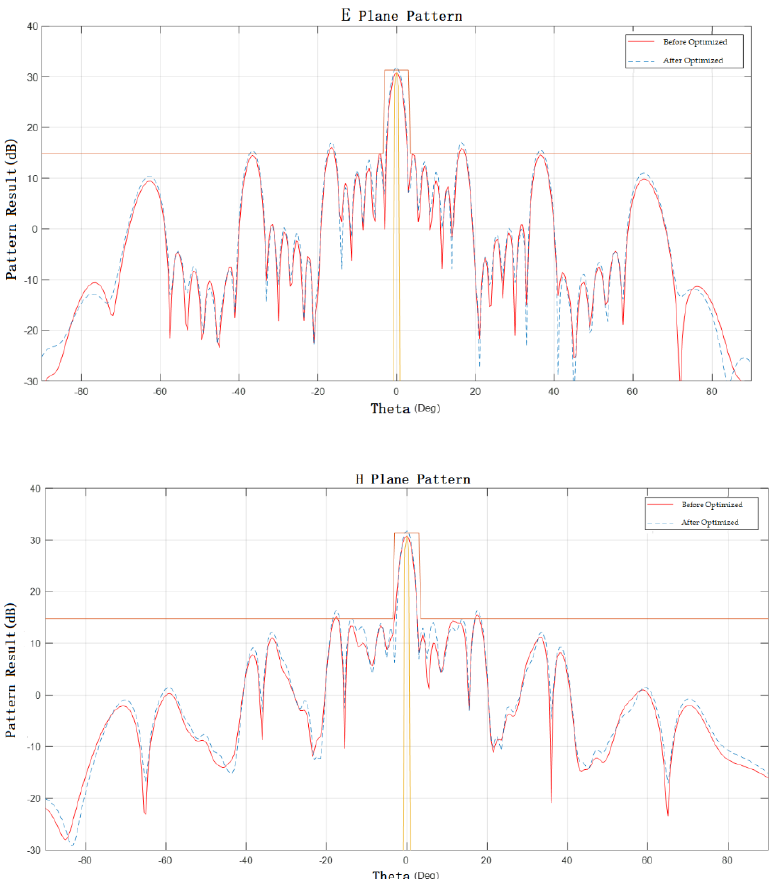
Figure 7. The E-plane and H-plane orientations of the array after optimization of the subarray Figure 7 The E ‐ plane and H ‐ plane orientations of the array after optimization of the subarray am ‐ amplitude–phase distribution at 0-degree scan angle. plitude–phase distribution at 0 ‐ degree scan angle.